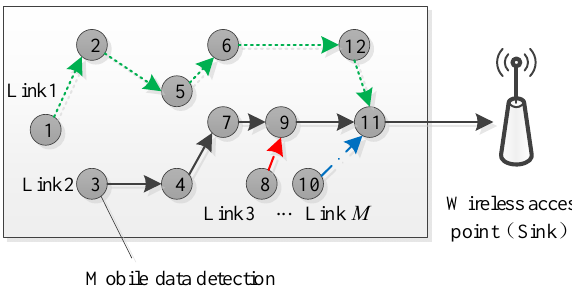
Figure 5. Compression collection model of gas flow data.